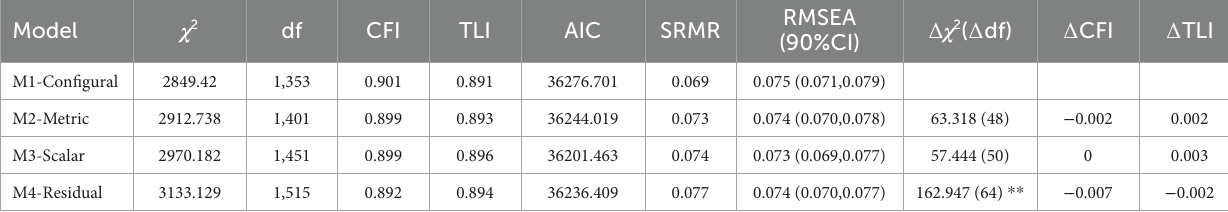
TABLE 7 Invariance Analysis across regions.